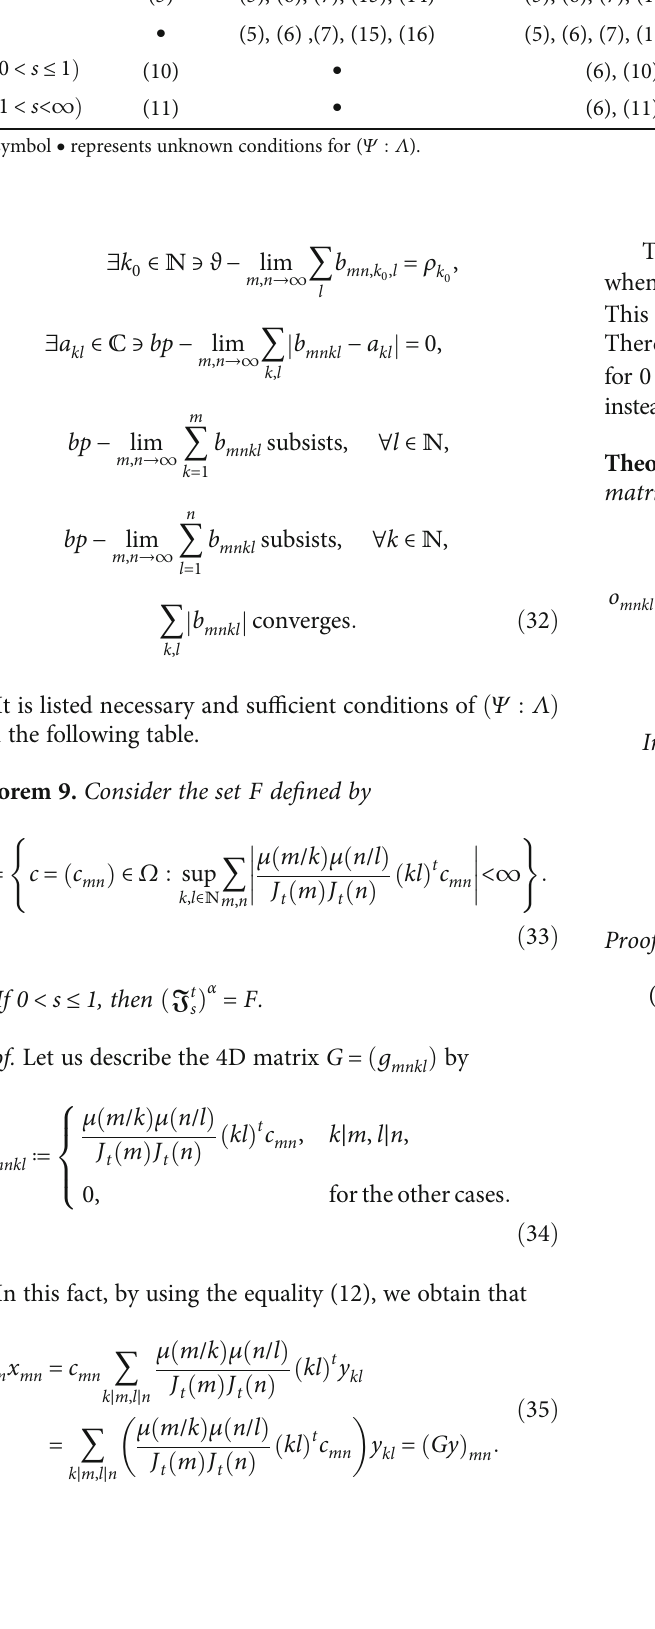
Table 3: Characterizations of ð Ψ : Λ Þ , where Ψ , Λ ∈ f M